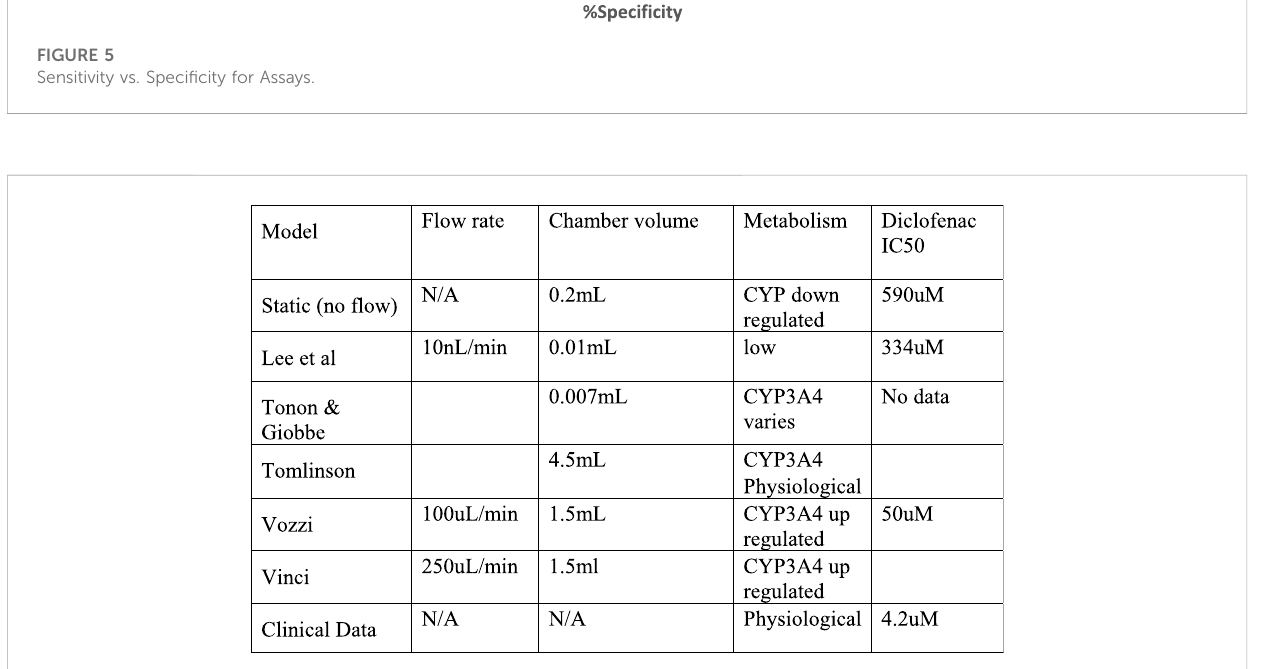
FIGURE 6 IC50 values for Liver